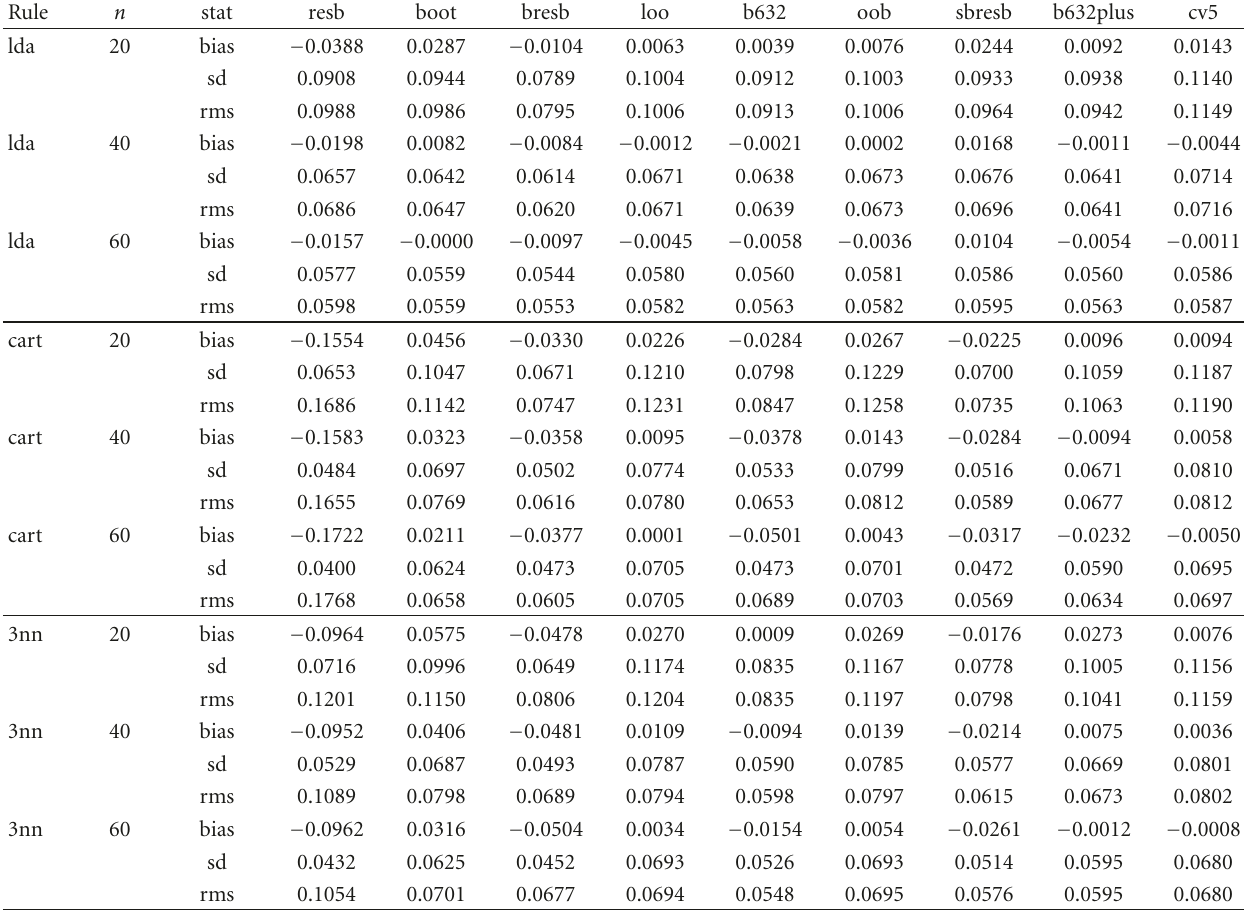
Table 1: Bias, variance (standard deviation), and RMS for di ff erent error estimators, with di ff erent base classification rules, for breast cancer gene expression data, and dimensionality p =